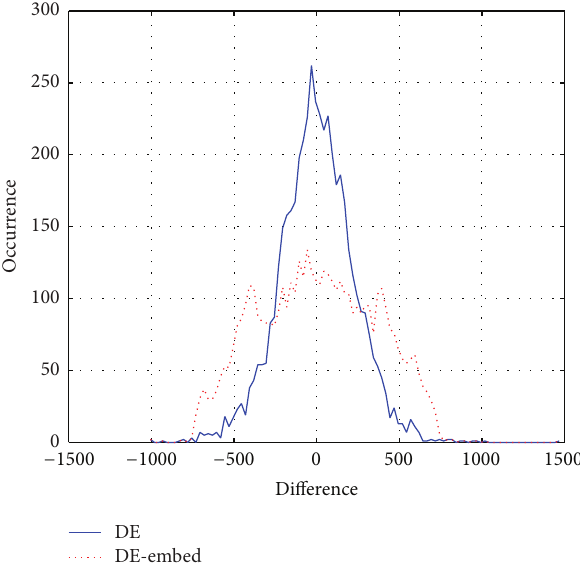
Figure 2: Histogram after expansion of inner region and original prediction